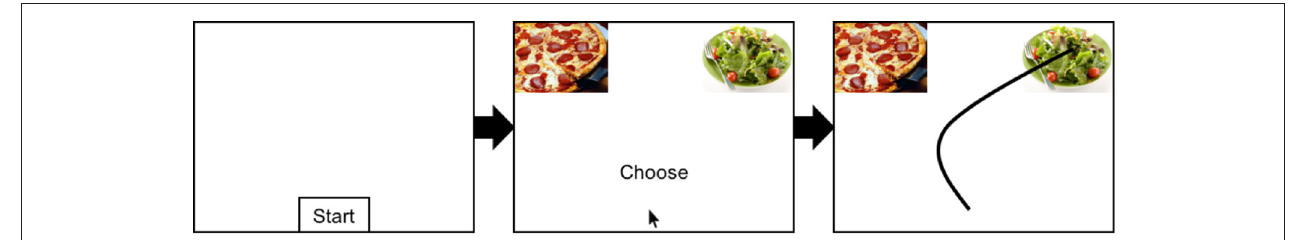
FIGURE 1 | Schematic depiction of a typical mouse-tracking trial. First, participants click on a start button at the bottom-center of the screen to initiate the trial, then two options (e.g., high and low calorie food items) appear at the top-left and top-right corners of the screen, respectively. Participants then freely move the mouse toward the desired